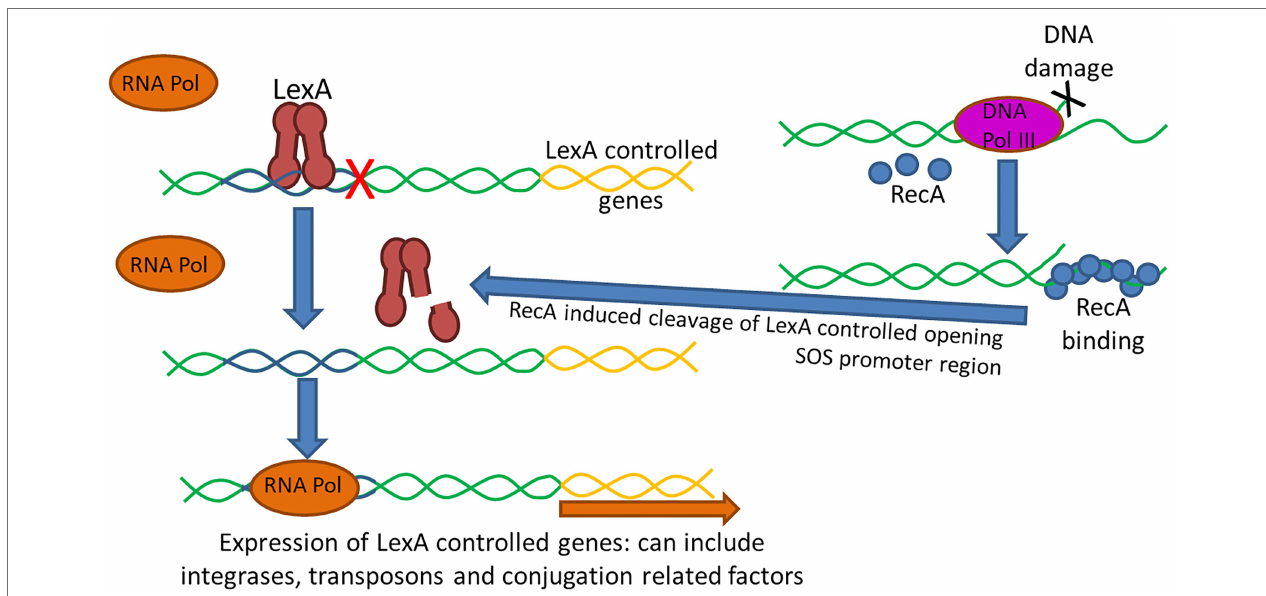
FIGURE 4 | The SOS response is an inducible DNA repair pathway controlled by two key regulators, the LexA repressor of gene expression and the RecA inducer. Under normal conditions, LexA is bound to the promoter of SOS-associated genes preventing binding of RNA polymerase (RNA Pol) and expression of the regulated genes (Maslowska et al., 2019). Following DNA damage, such as following certain antimicrobial exposures, the DNA polymerase III (DNA Pol III) enzyme senses the damage and the increase in single-stranded DNA (ssDNA) causes RecA to become activated and bind to the ssDNA. The ssDNA/RecA complex leads to proteolysis of the LexA repressor allowing RNA polymerase to bind facilitating expression of genes under LexA control. LexA has been shown to impact the expression of integrases and transposases, as such the activation of the SOS response has been shown to promote horizontal dissemination of resistance genes. Additionally, conjugation can also trigger the SOS response as ssDNA is generated and transferred during the conjugation process which can upregulate integrase and transposase expression and triggering recombination of plasmids in the recipient